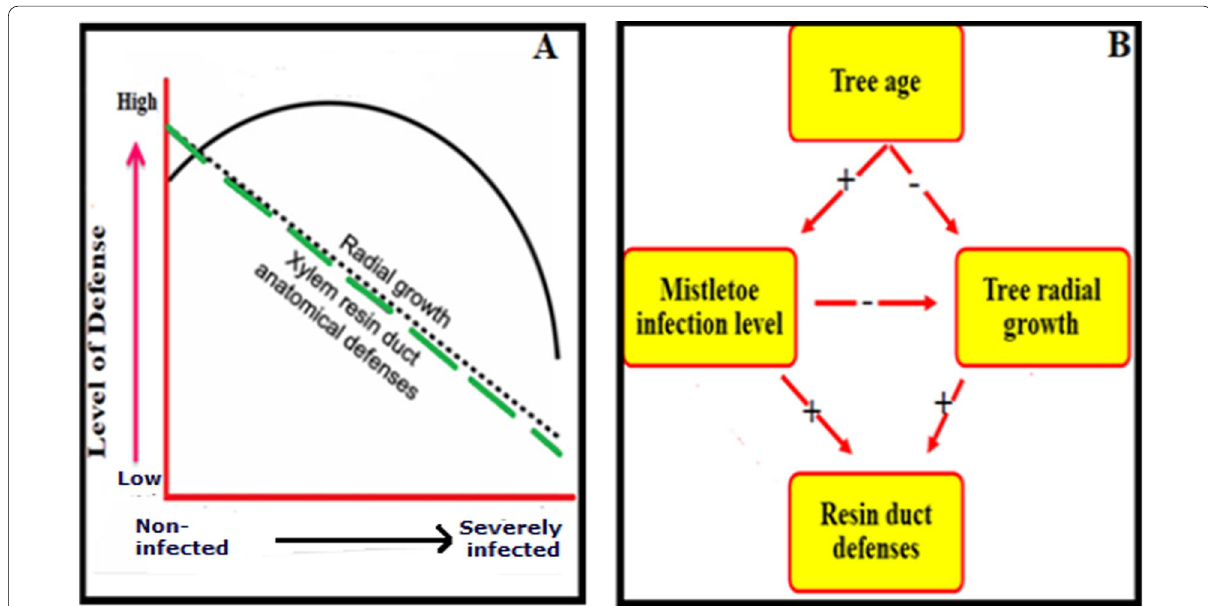
Fig. 3 Levels of resin production with mistletoes infestation. A The change in resin defense chemical production of dwarf mistletoe ( Arceuthobium americanum ) infection of jack pine tree ( Pinus banksiana ), whereby the green solid lines is the xylem resin level and the black dots are the radial growth with the infestation level and B the hypothesized model of resin duct defenses as a function of mistletoe infection, tree age and growth rate (Sources: Klutsch and Erbilgin 2018; Ferrenberg